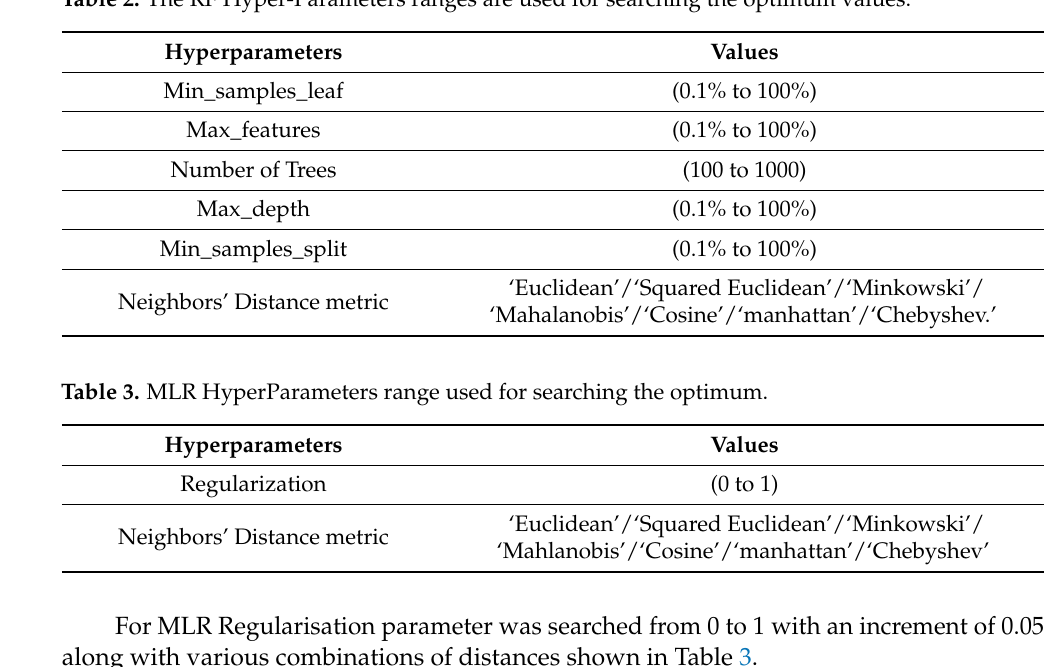
Table 2. The RF Hyper-Parameters ranges are used for searching the optimum values.